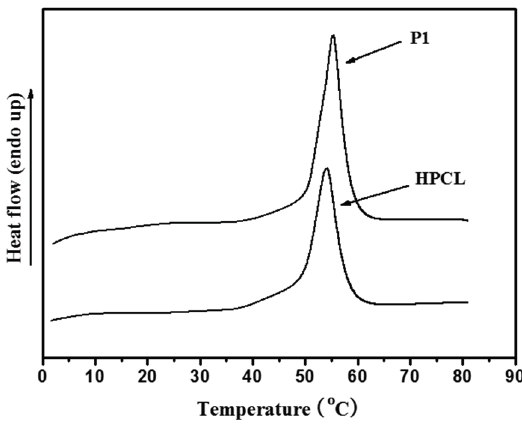
Figure 7. Second DSC heating curves of the linear poly( ε -caprolactone) (P1, M n GPC = 7400 g/mol, M w / M n = 1.15) and hyperbranched poly( ε -caprolactone) (HPCL, M n GPC = 25,500 g/mol, M w / M n = 2.38).